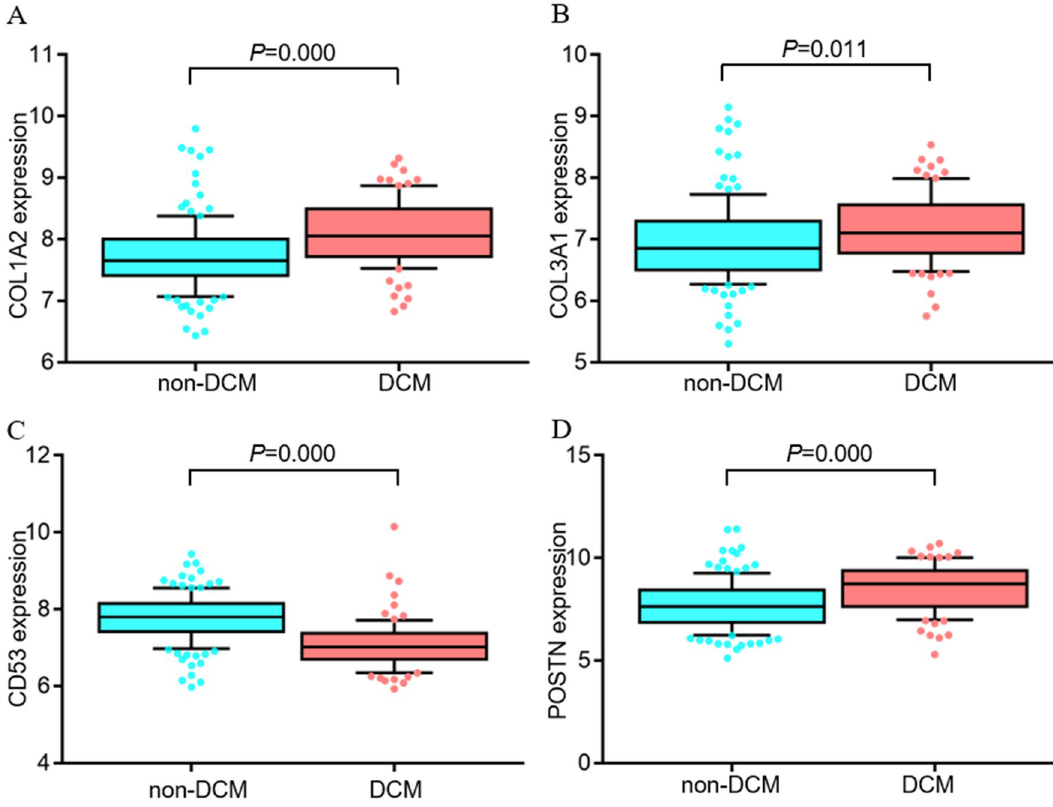
Figure 9. The expression levels of the four potential immune-related genes in validation set of GSE57338. ( A ) The expression level of COL1A2 , ( B ) The expression level of COL3A1 , ( C ) The expression level of CD53 , and ( D ) the expression level of POSTN